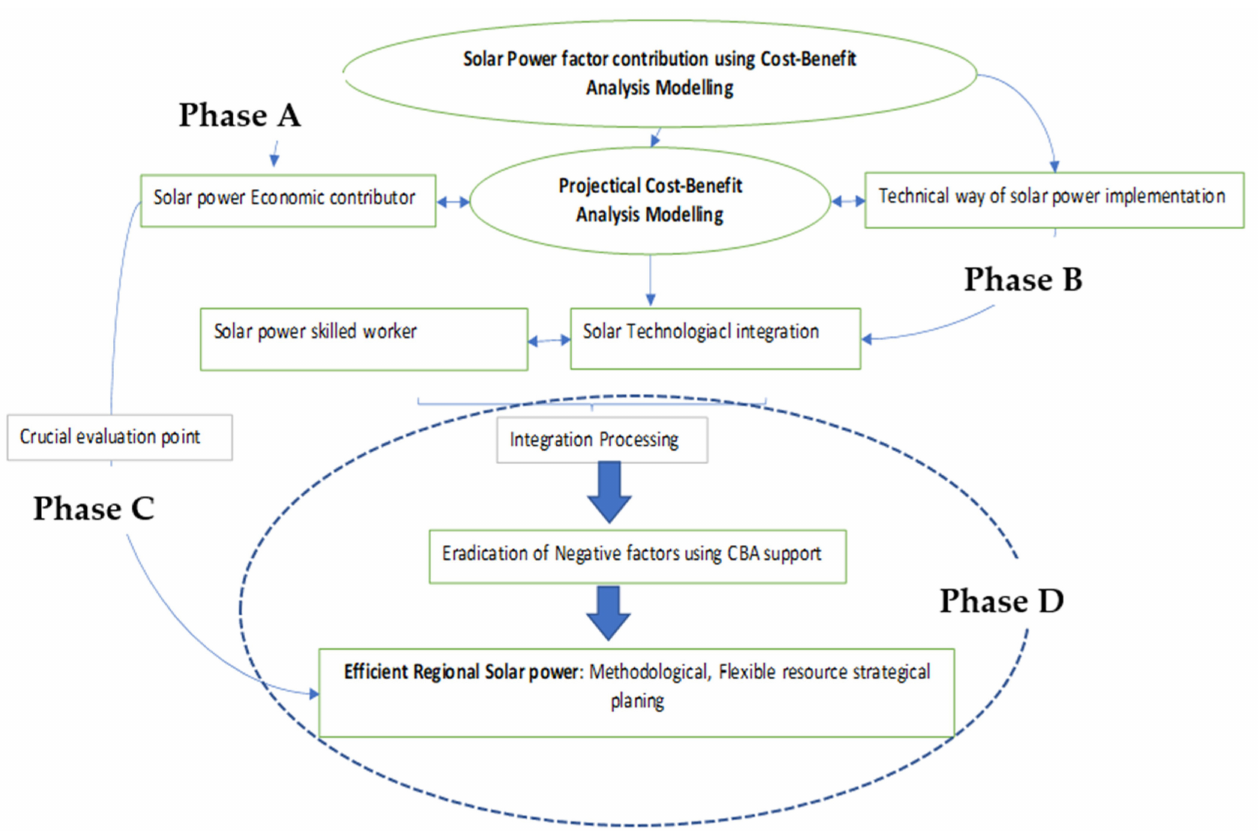
Figure 4. Proposed Solar Power (SP) sustainability analysis framework for